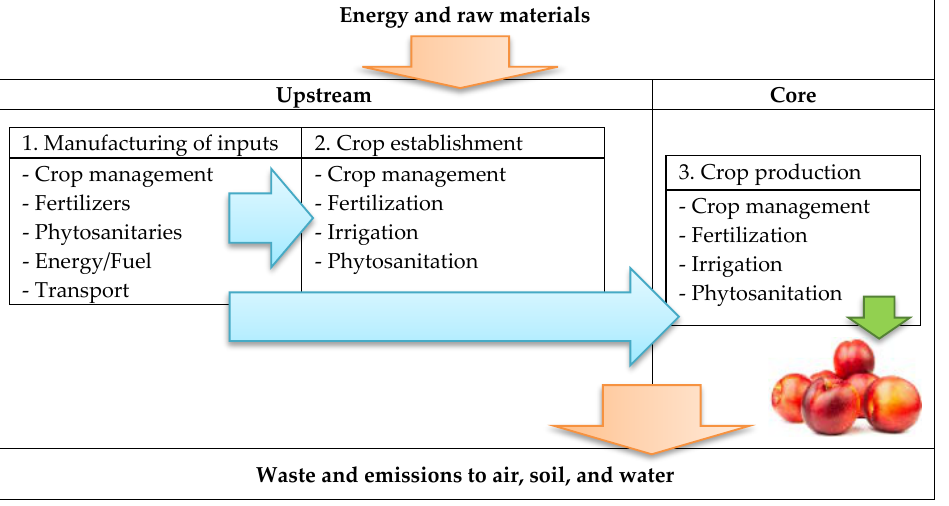
Figure 1. Life cycle diagram and system boundaries of the nectarine product system using the cradle-to-farm gate approach.